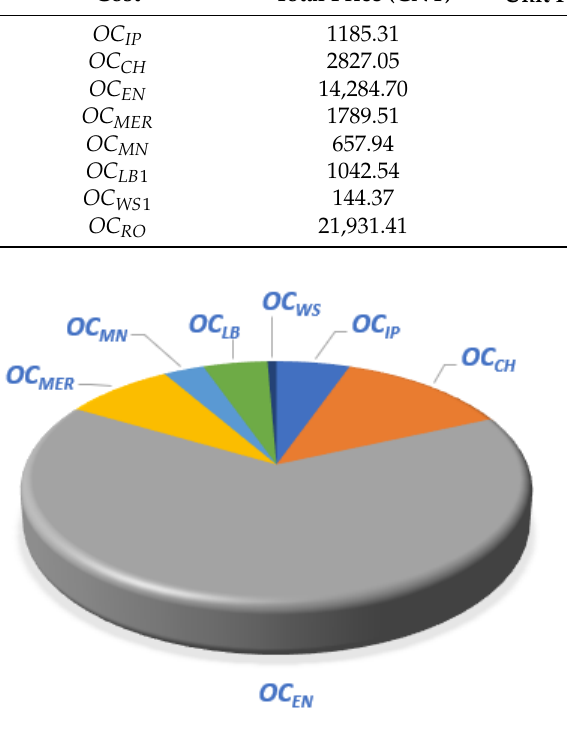
Figure 8. SWRO cost proportion analysis.